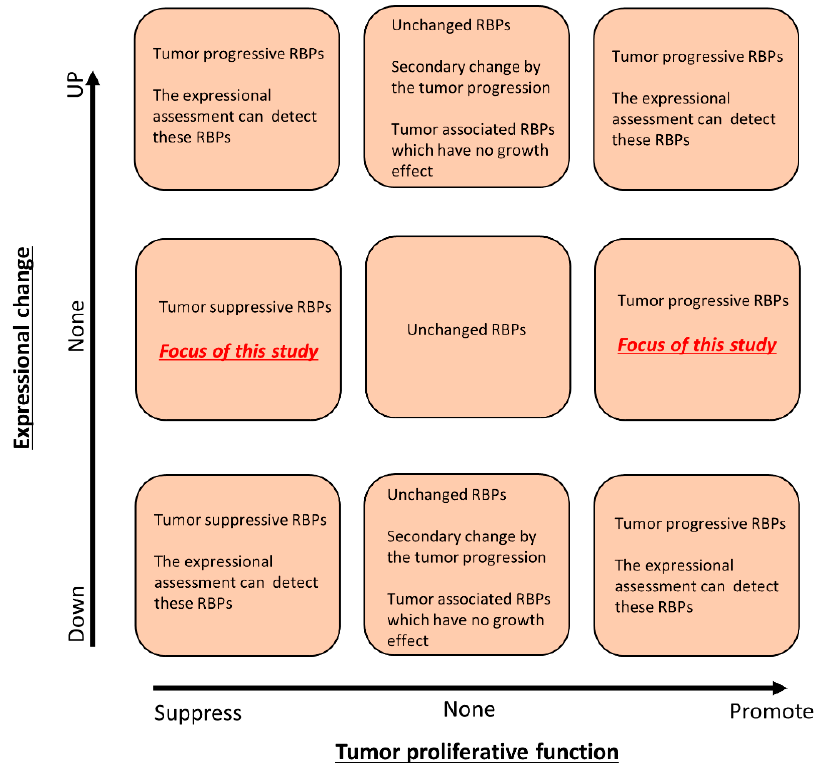
Figure 1. Schematic depiction of the functional and expressional screening of RBPs. A functional analysis of the siRNA library identified RBPs that promote or suppress tumor cell growth, and a gene expressional analysis using cDNA microarray identified RBPs whose expression was abnormally changed in cancer cells. In this study, we focused on the tumor proliferation-related RBPs whose expression was not changed in cancer cells compared to non-cancer cells.